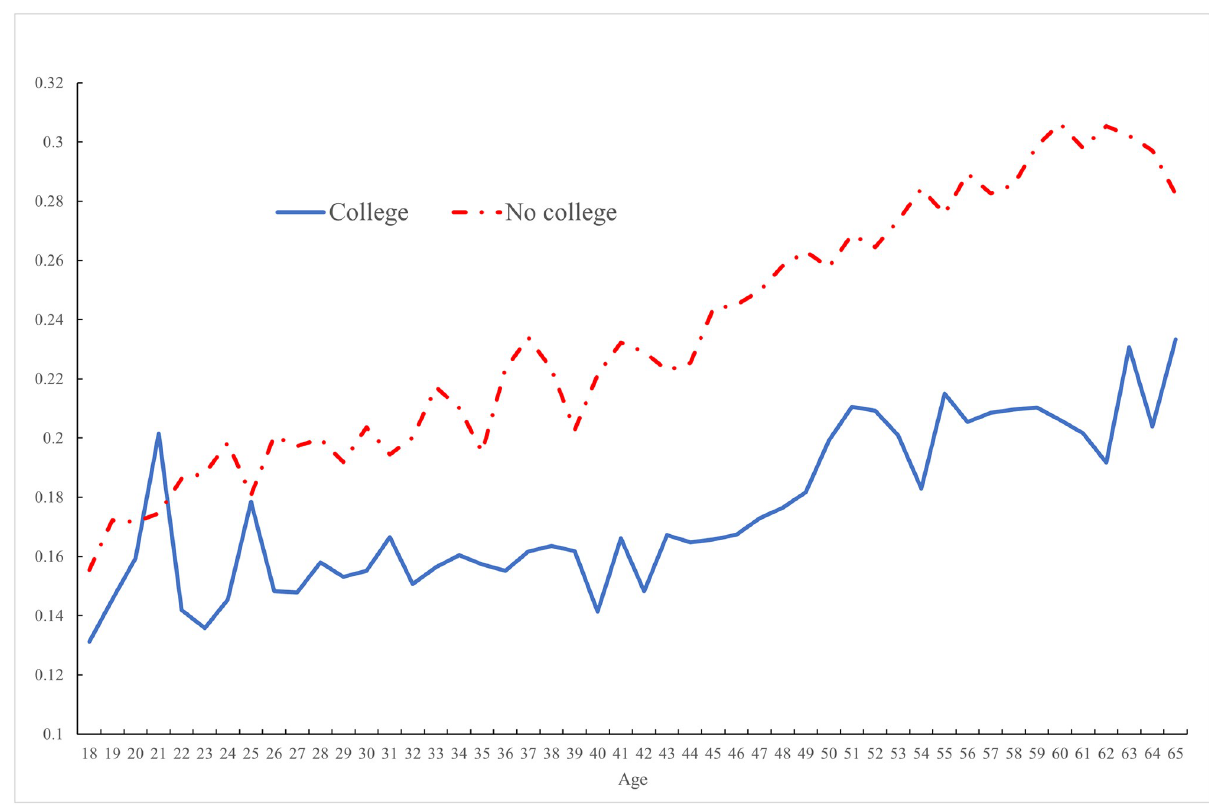
Fig 3. Pain in OECD 20 countries by education group,